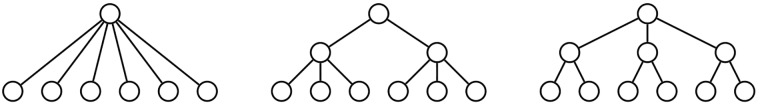
Three fully symmetric trees with 6 leaves: From left to right, FS6, FS2,3 and FS3,2.